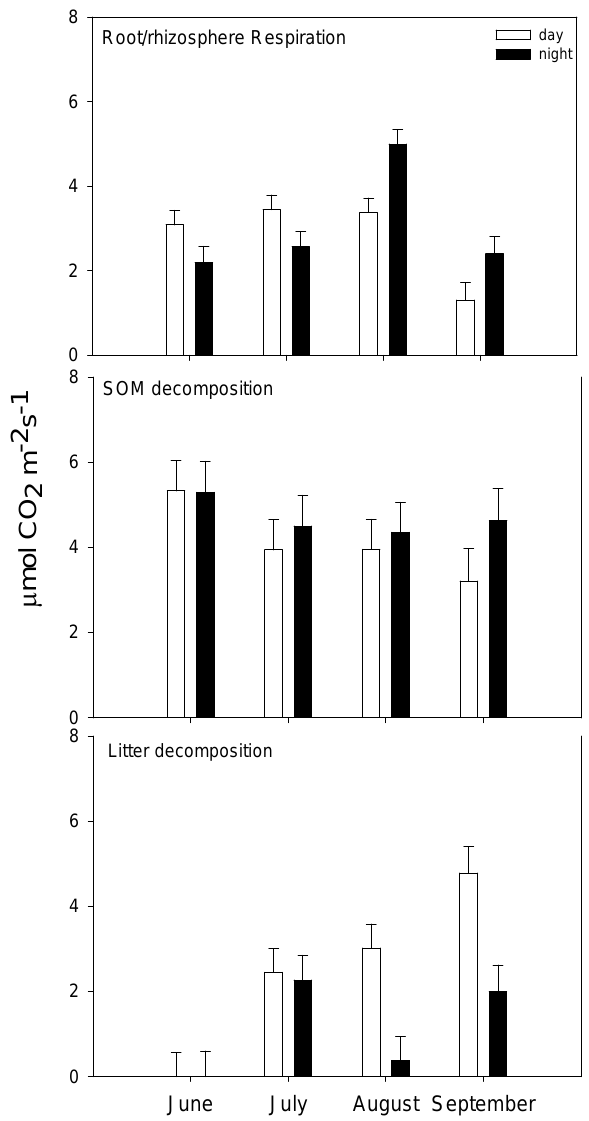
Fig. 3. The rates of the root, soil organic matter, and litter respira- tion components of soil respiration during the day (open bars) and at night (closed bars) in 2004 at FACTS-1. Values are means ( n = 3) ± standard